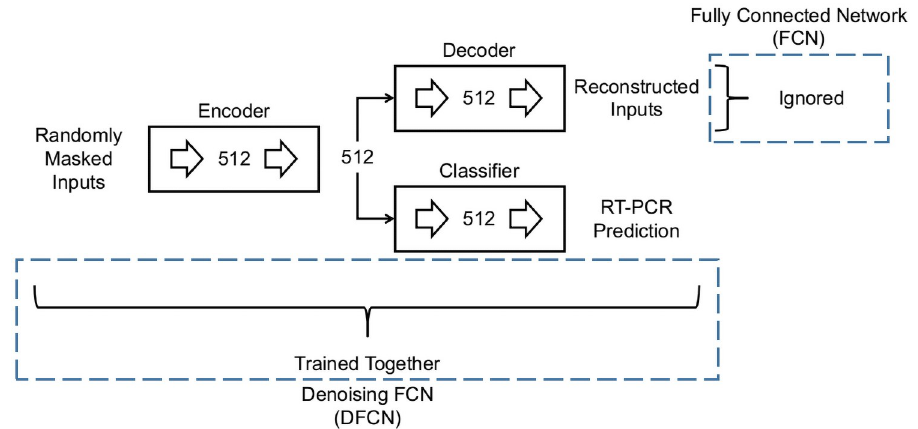
Fig 3. Architectures of DFCN and FCN. DFCN is trained using randomly masked inputs and uses the reconstruction of the inputs as a regularizer during the training process. FCN ignores the reconstruction objective. Numbers of neurons are indicated alongside the fully connected layers (large right arrows).